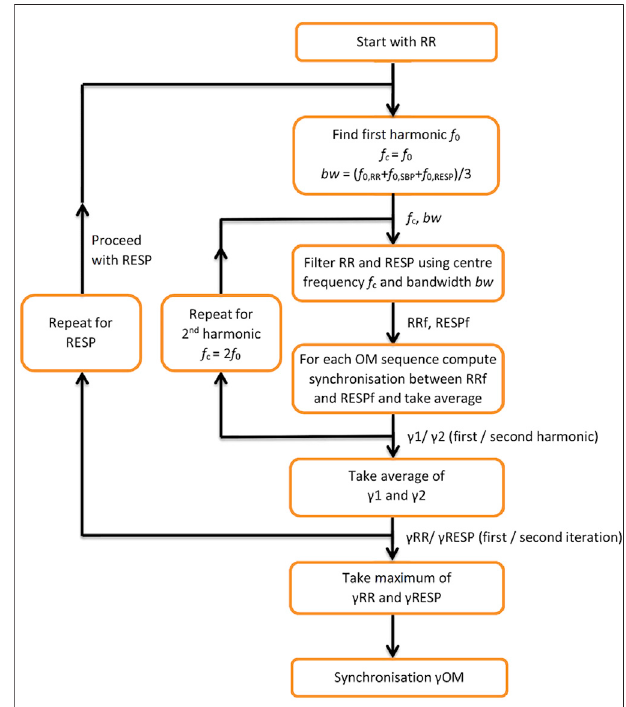
FIGURE 1 | Flow diagram for computing synchronisation between RESP and RR during OM. f 0 — fi rst harmonic; f c — centre frequency; bw — bandwidth; RR f , RESP f — band passed RR tachogram and RESP signal at centre frequency f; y 1 , y 2 — synchronisation indices for the fi rst and second harmonic; γ RR — average of y 1 , y 2 ; γ RESP — synchronisation index applied to RESP as a reference; γ OM — resulting synchronisation